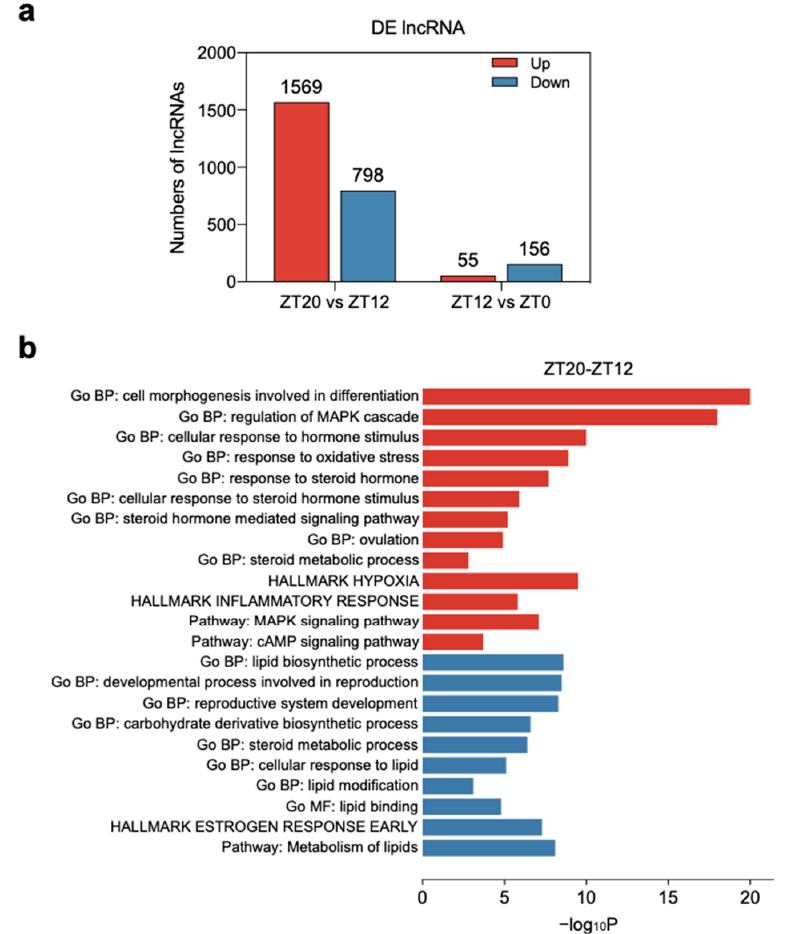
Figure 4. Gene ontology (GO) and pathway analysis of differentially expressed genes (DEGs) during follicle development in the chicken ovulatory cycle. ( a ) Number of DELs in pairwise stages. ( b ) Enriched GO terms (up) and pathways (bottom) of DEGs in ZT20 vs. ZT12 group. The up-regulated (red) and down-regulated (blue) gene numbers and gene ontology terms are shown.